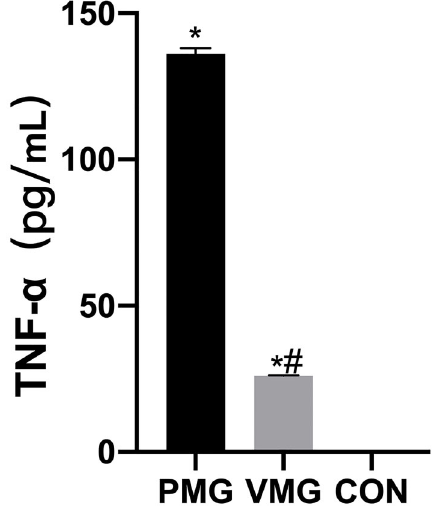
Figure 5. Comparison of serum tumor necrosis factor- a (TNF- a ) levels of children. VMG: viral meningitis group; PMG: purulent meningitis group; CON: control group. Data are reported as means ± SD. *P o 0.05, vs CON group; # P o 0.05, vs PMG (ANOVA).